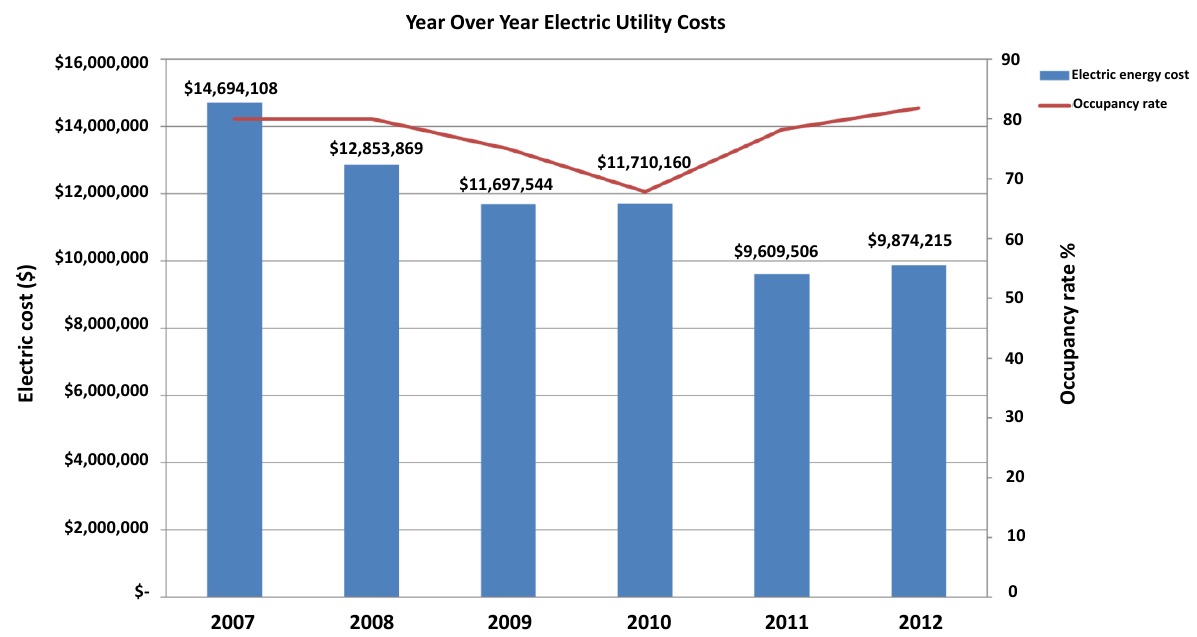
Figure 2. Empire State Building (ESB) Performance Year 2. Reduction in ESB’s 2007 Baseline Electric Utility Costs during Performance Period (Graph by author; redrawn from [29]).